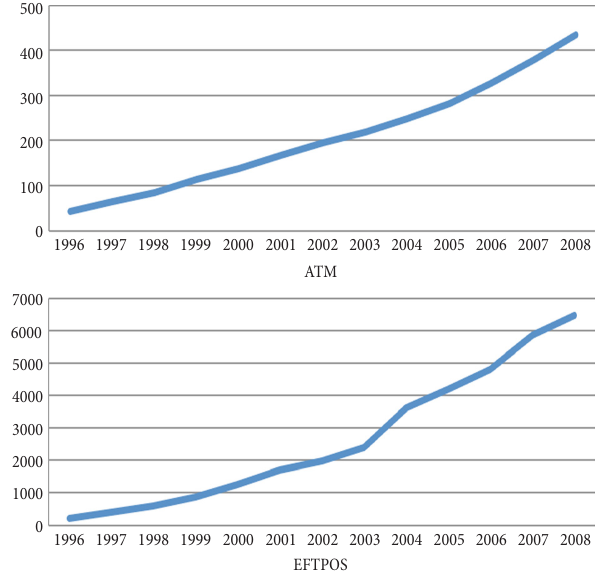
Fig. 2. ATM and EFTPOS evolution (number of facilities per 1 million